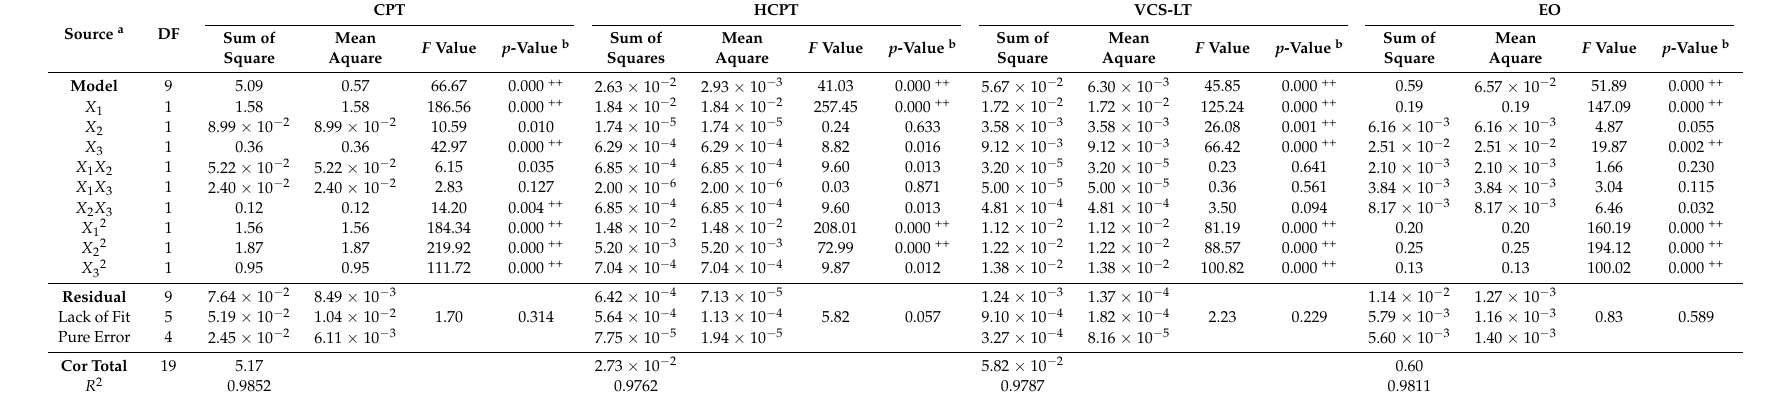
Table 2. ANOVA of the response surface quadratic model for the yields of CPT, HCPT, VCS-LT, and